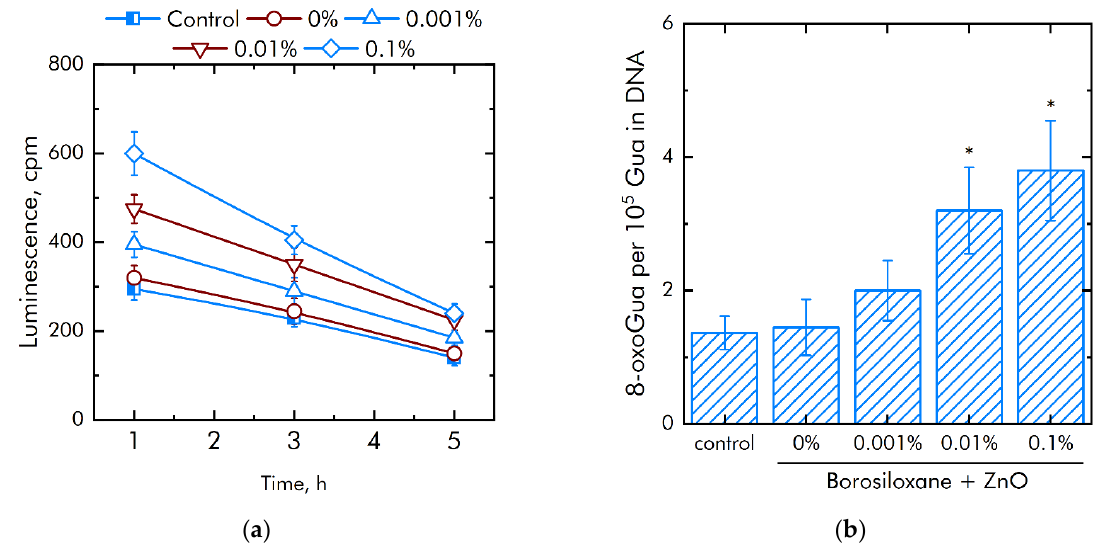
Figure 6. Effect of composite material containing borosiloxane and ZnO nanoparticles on the generation on biomacromolecules damage: ( a ) Formation of long-lived reactive protein species (2 h, 40 °C); ( b ) Generation of 8-oxoguanosine (2 h, 45 °C); * indicate a significant difference at 5% level in comparison with the control ( p < 0.05). Data are presented as mean values and standard errors.